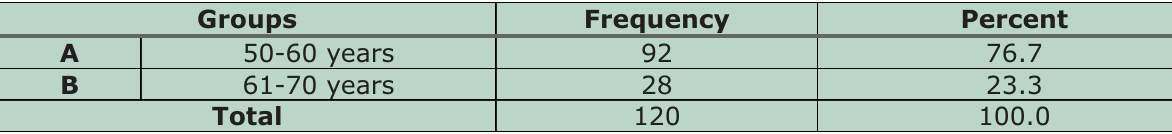
Table-I: Age Distribution (n=120).